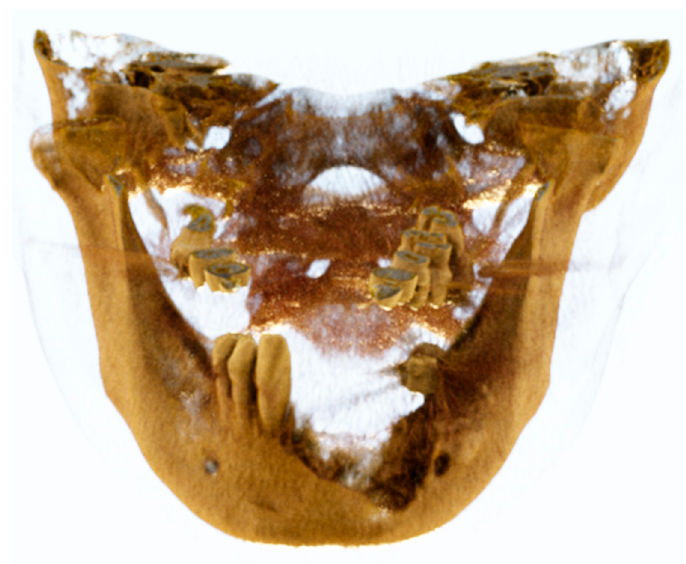
Figure 1. Computerized tomography (CT) scan that showed the presence of a tumor mass in the anterior region of the mandible.